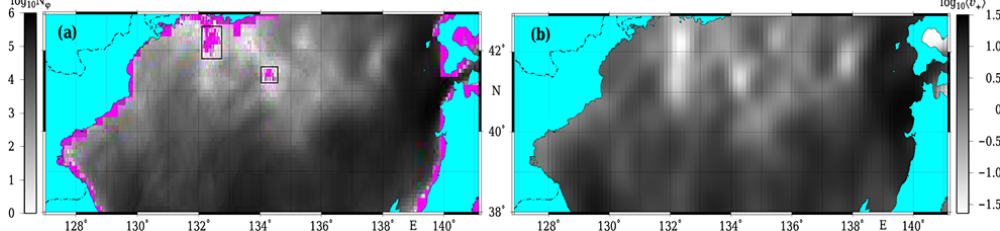
Figure 2. (a) The logarithmic-scale density of tracks of the tracers crossing all the latitudes ϕ in the central JS, N ϕ , from 2 January 1993 to 15 June 2015. The rectangular magenta areas are forbidden zones where the northward transport has not been observed during the whole integration period. The magenta areas near the coast mean that the AVISO grid cells there touch the land, and we did not compute trajectories there. The tracers have been launched weekly along the zonal line at 37 ◦ N from 2 January 1993 to 15 June 2013. (b) Distribution of the averaged northward component of the AVISO velocity field (cid:104) v + (λ,ϕ) (cid:105) in the logarithmic-scale averaged over the same period.